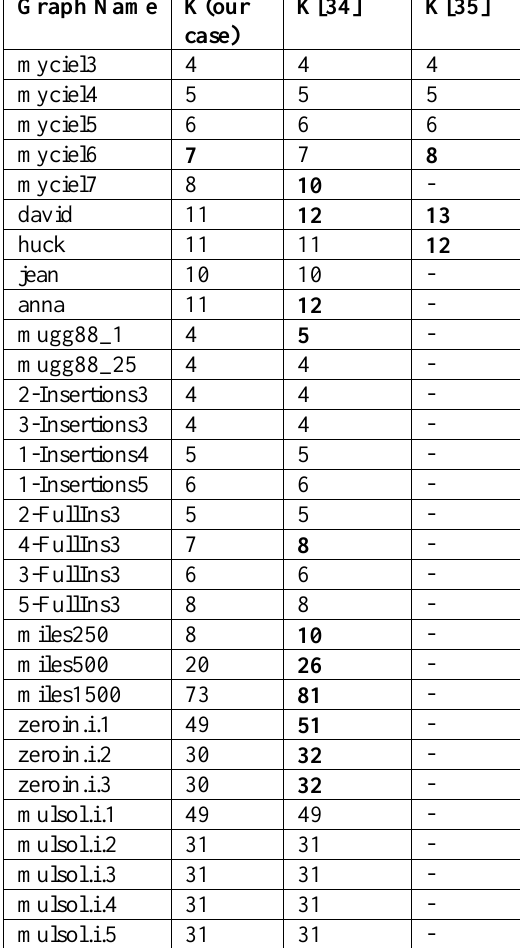
Table 9: Comparison results with [34] and